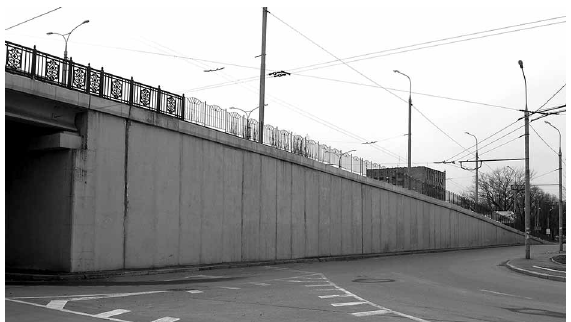
Fig. 1. The general view of the auto-road overpass and the strengthening fencing structures